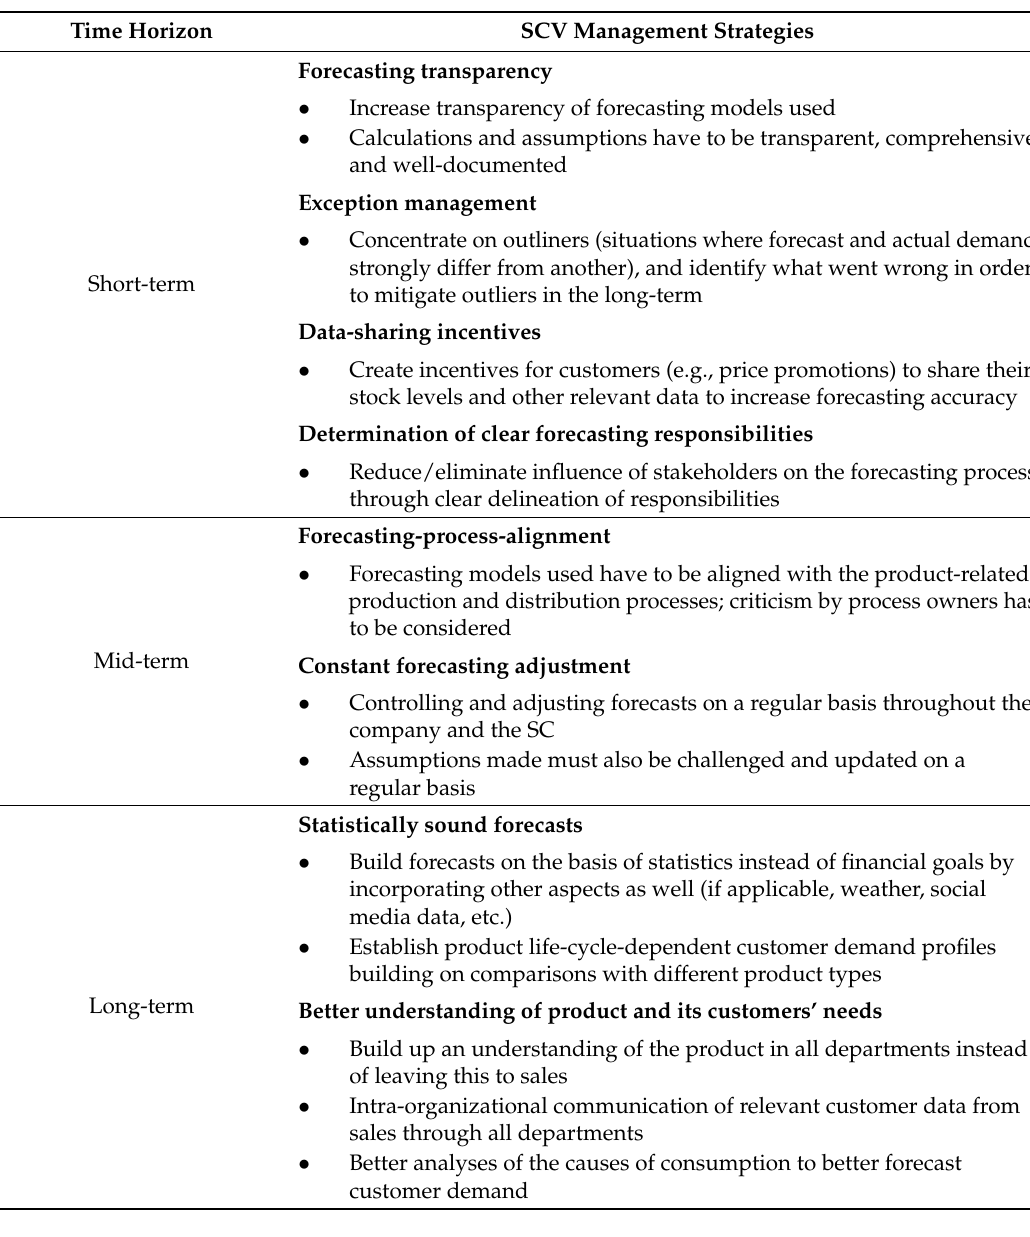
Table 7. SCV management strategies dealing with long lead times. Time